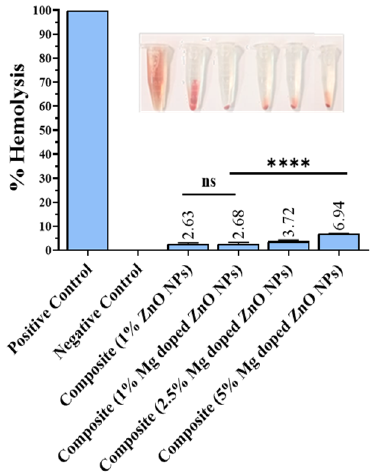
Figure 7. % Hemolysis of composites with bare and Mg-doped ZnO NPs at varying concentrations. p -value < 0.0001 is flagged with four stars (****), while ns (not significant) represents statistically insignificance.